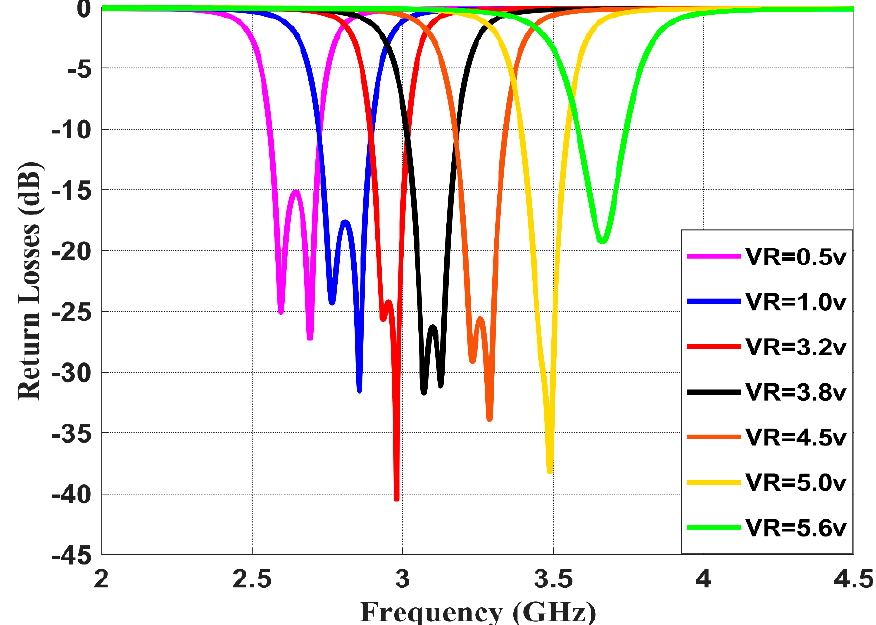
Figure 11. Simulated return losses with different DC reverse bias voltages for the presented reconfigurable filter.